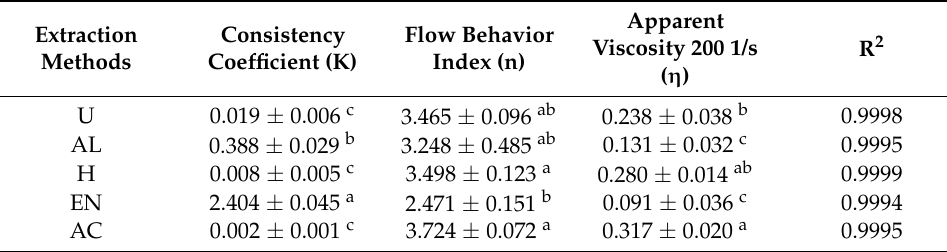
Table 2. Consistency coefficient, flow behavior index and apparent viscosity of Sanchi flower dietary fiber extracted by different methods.